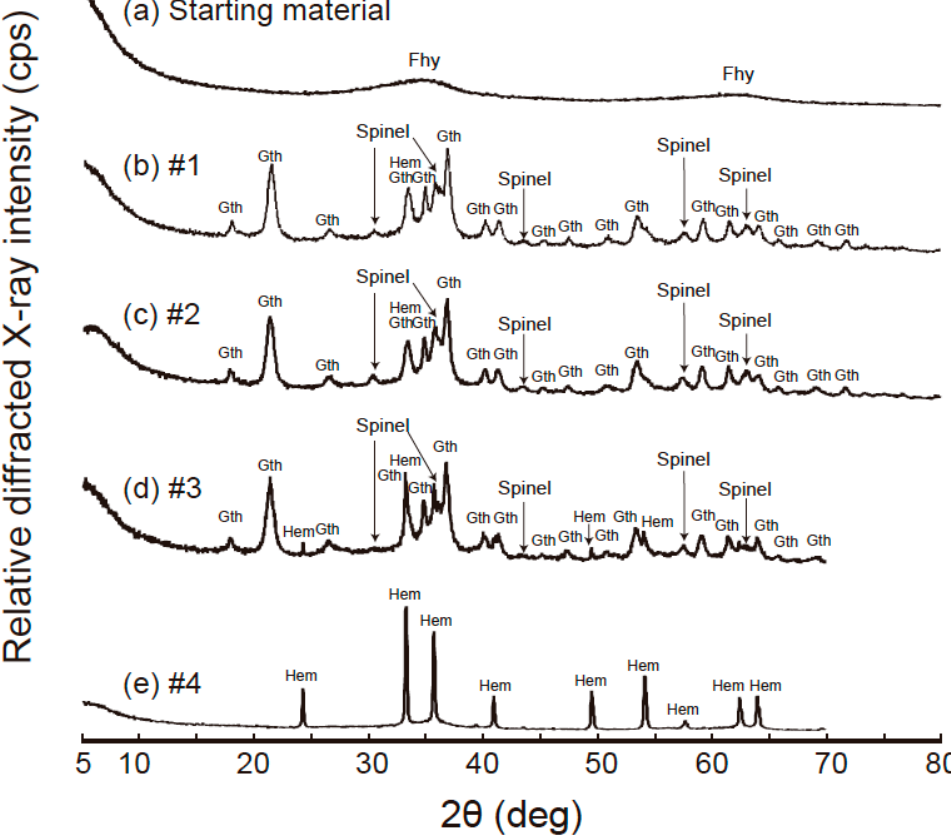
Figure 4. XRD profiles of ( a ) the starting material and solid samples from runs ( b ) 1, ( c ) 2, ( d ) 3, and ( e ) 4 recovered from Cell 2 after the experiments. Fhy: Ferrihydrite, Gth: Goethite, Hem: Hematite.